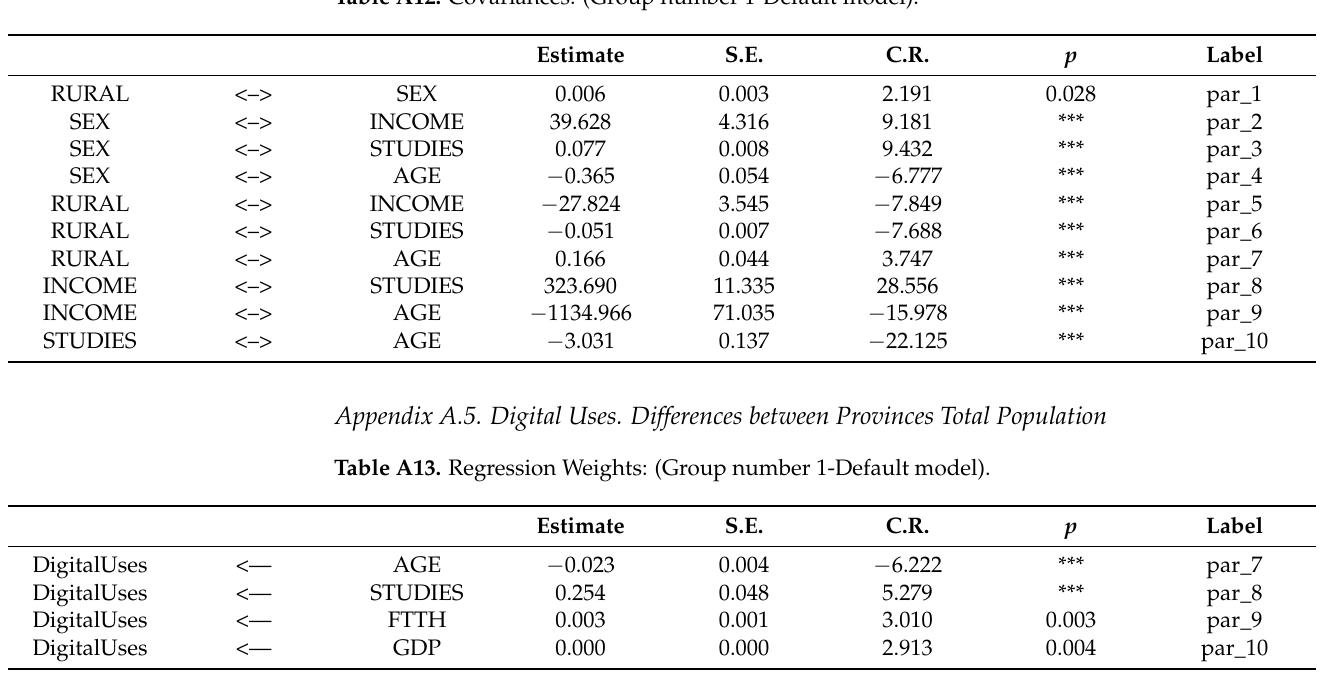
Table A12. Covariances: (Group number 1-Default model).